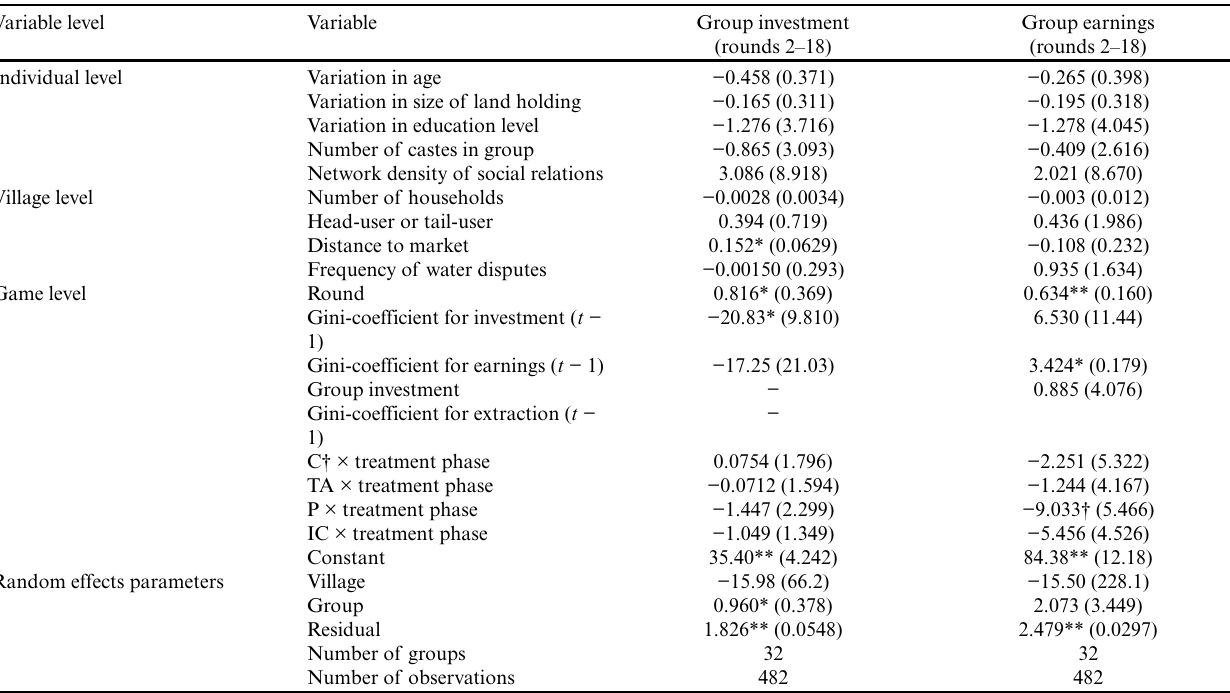
Table 4. Mixed-effects regression results explaining the total tokens invested and earned by groups. Numbers are coefficients, with robust standard errors in